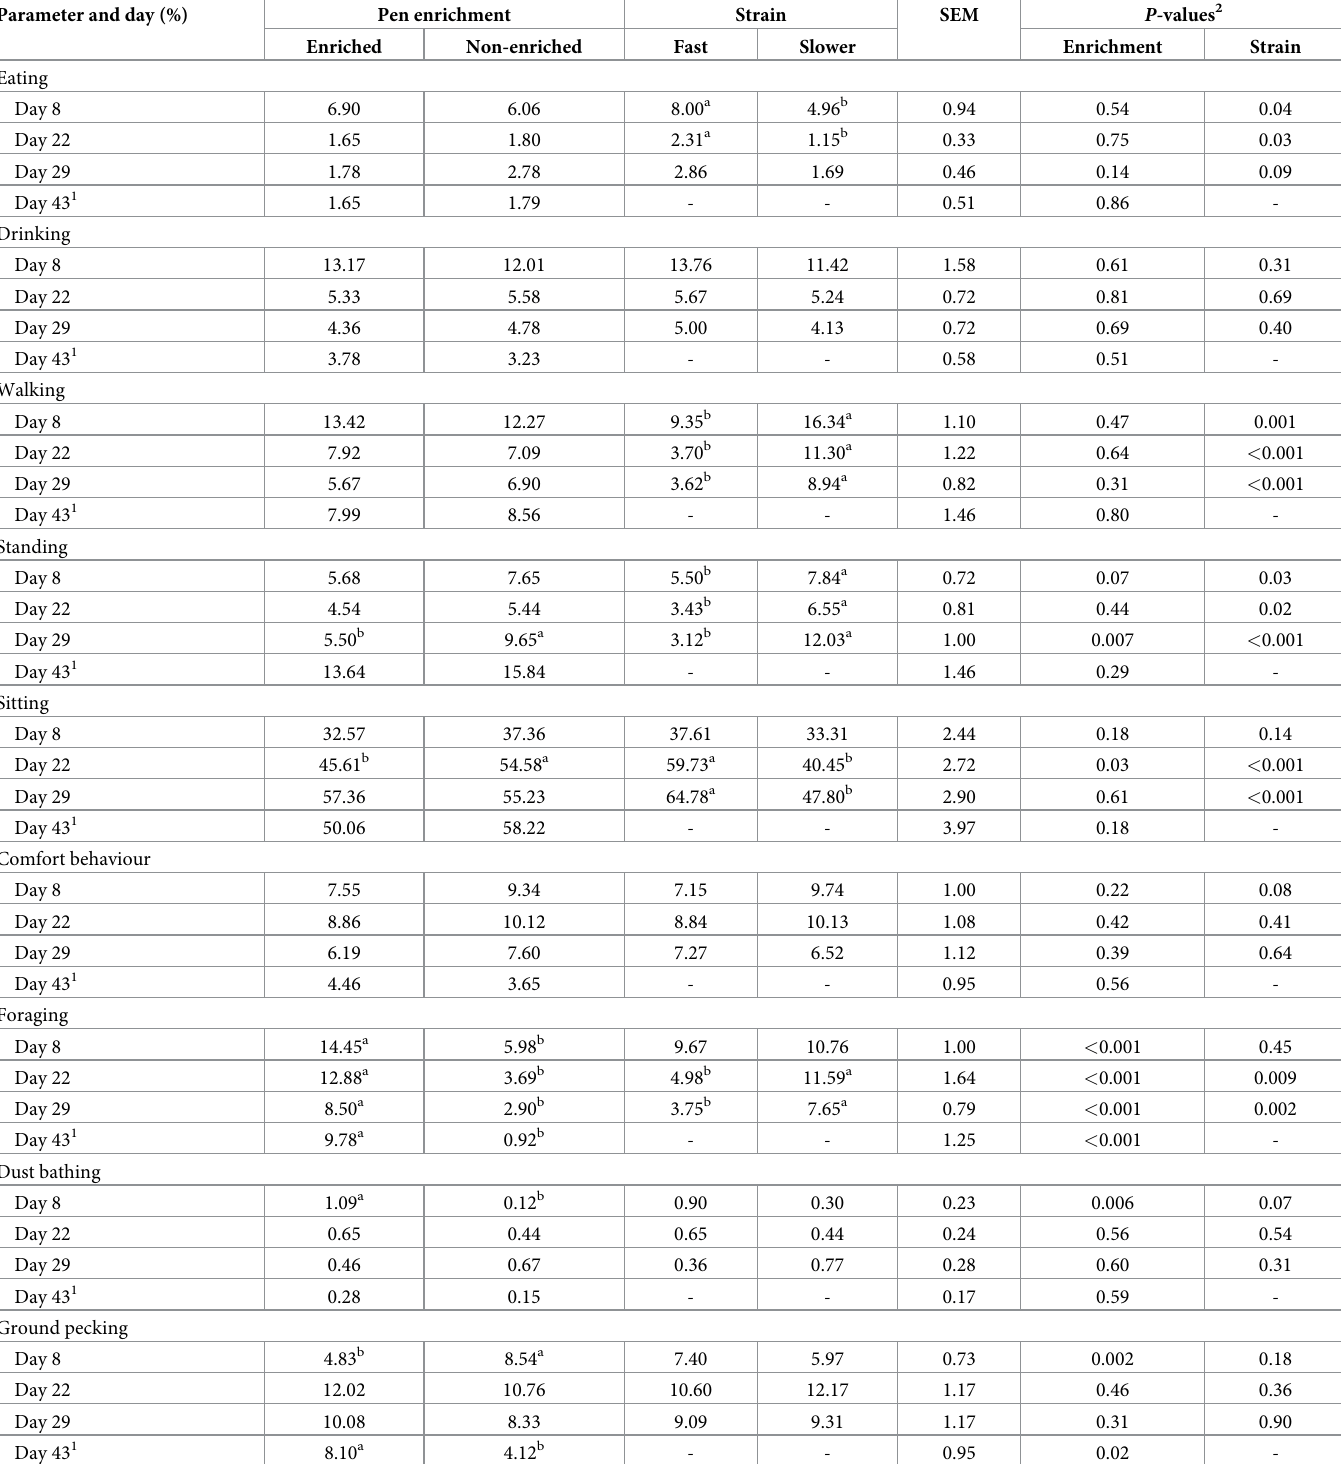
Table 6. Effects of pen enrichment (enriched or non-enriched) and broiler strain (fast-growing ross 308 or slower-growing Hubbard JA 757) on percentage of male chickens showing eating, drinking, walking, standing, sitting, comfort behaviour, foraging, dustbathing, ground pecking, aggression and other behaviours at day 8, 22, 29 and 43 of age (n = 7 pens per treatment; LSmeans ± SEM). Parameter and day (%) Pen enrichment Strain SEM P -values 2 Enriched Non-enriched